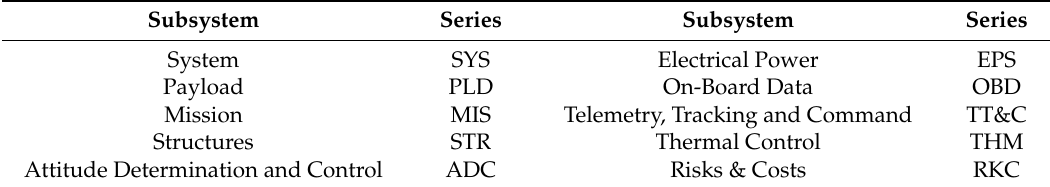
Table 9. Subsystem codification.